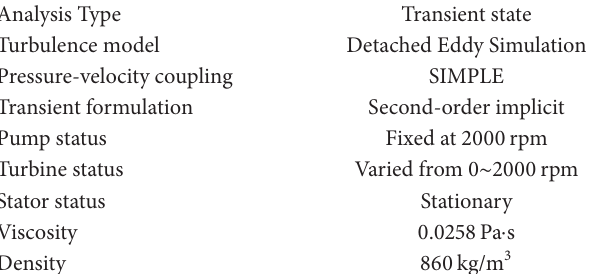
Table 2: CFD model